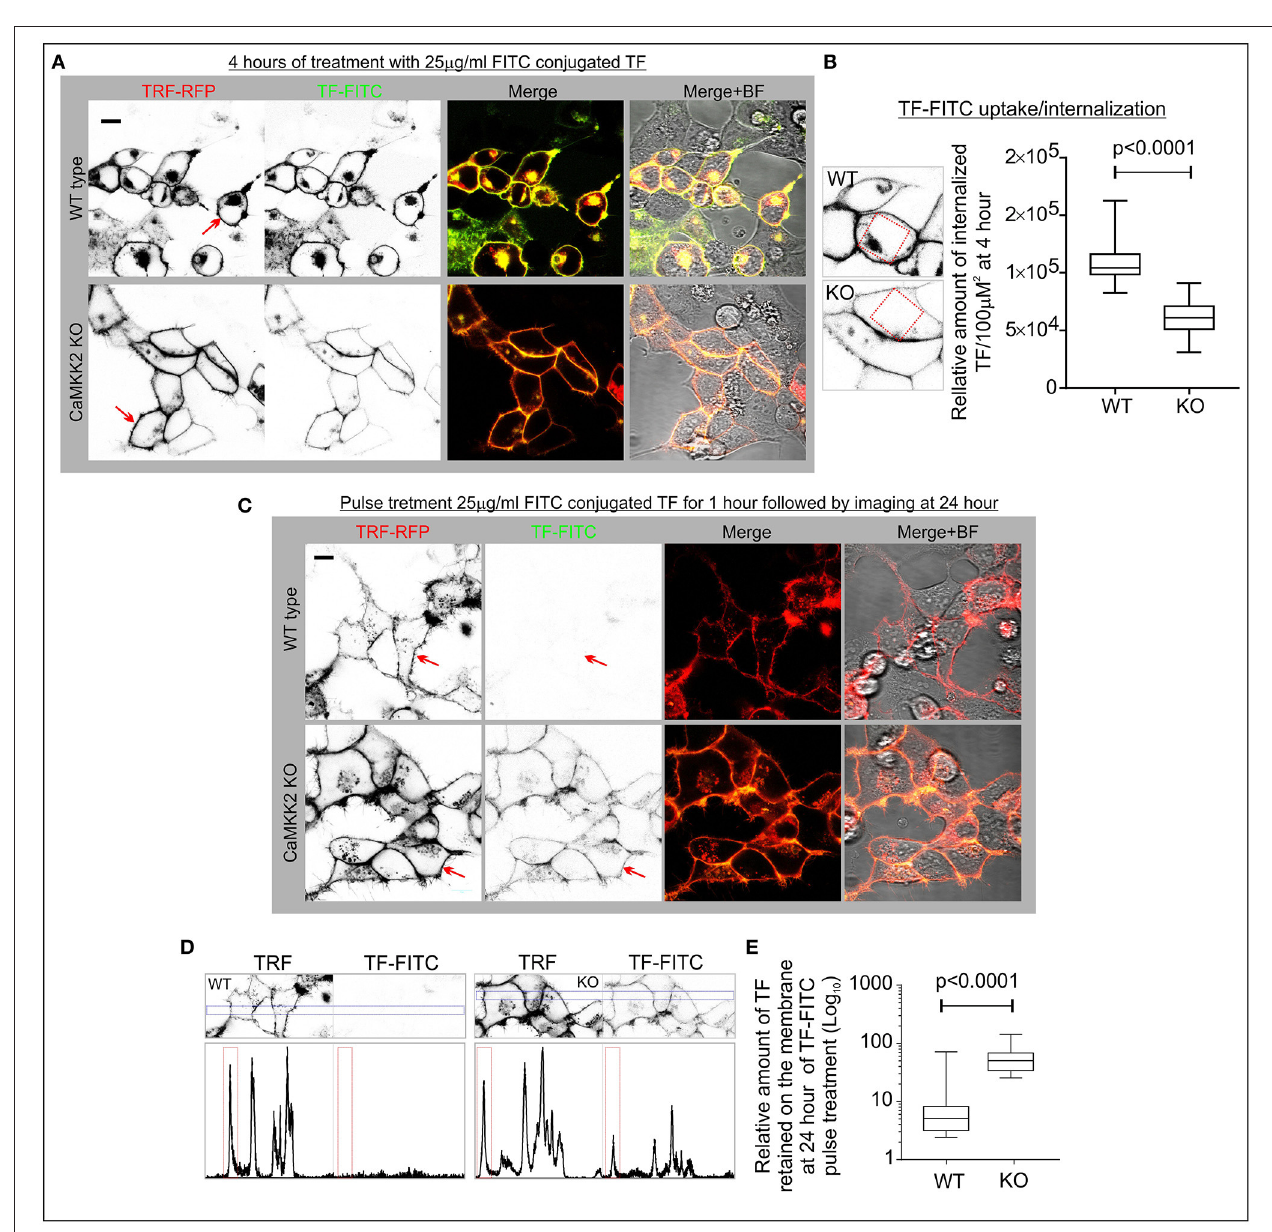
FIGURE 4 | Aberrant TF uptake and trafficking in the CaMKK2 KO HEK293 cells. (A) Live confocal fluorescent images showing localization of FITC-TF and RFP-TFR in the wild-type and CaMKK2 KO cells. The red arrow indicates the membrane localization of TFR. (B) Whisker plot showing relative intensity of the internalized TF. Red square represents 100 µ M 2 intracellular area used to measure the relative intensity of internalized TF. The p -value calculated by t -test (unpaired). (C) Live confocal fluorescent images showing membrane-bound FITC-TF after 24h of incubation in serum-free media following pulse treatment with 25 µ g/ml FITC-TF for 4h. The red arrow indicates the membrane localization of TFR and FITC-TF. (D) The red and green channel images presented in (C) were stitched together to create an intensity profile plot for the blue rectangular marked area. The profile plot was then used for calculating the relative percentage of membrane-bound FITC-TF. The peak area in the red rectangles represents membrane-associated TFR and FITC-TF. All confocal (Zeiss, LSM510) images were taken using the same image acquisition parameters for the wild-type and CaMKK2 KO cells. The image analysis was performed using ImageJ software. (E) Whisker plot showing relative percentage of TF associated with the membrane. N = 50 from 2 independent experiments. The p -value calculated by t -test